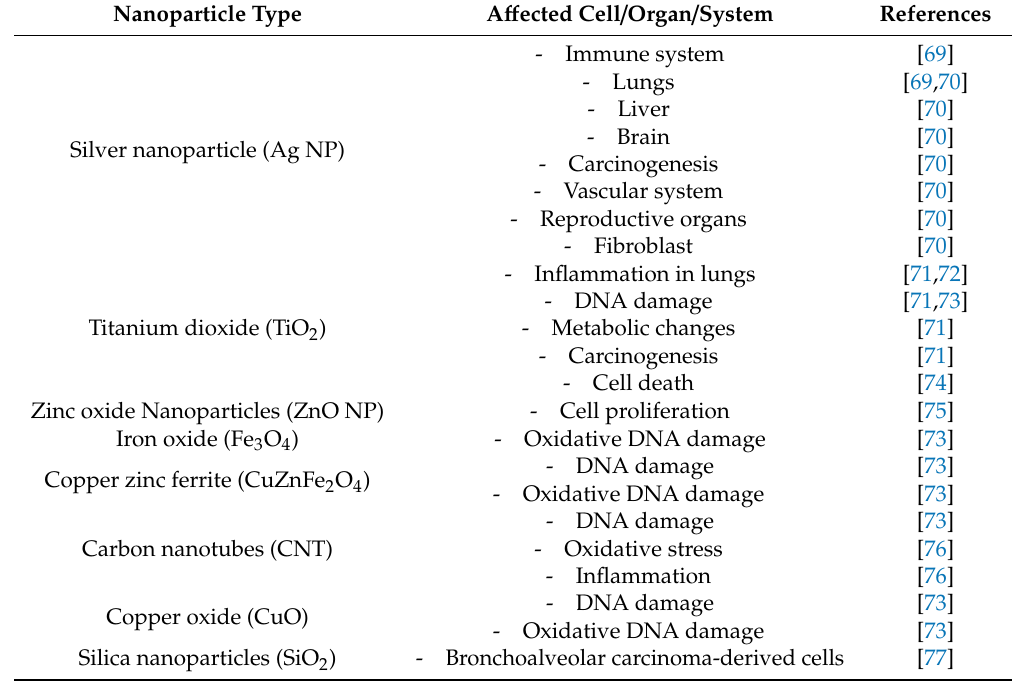
Table 3. Health implications of nanoparticles to the human